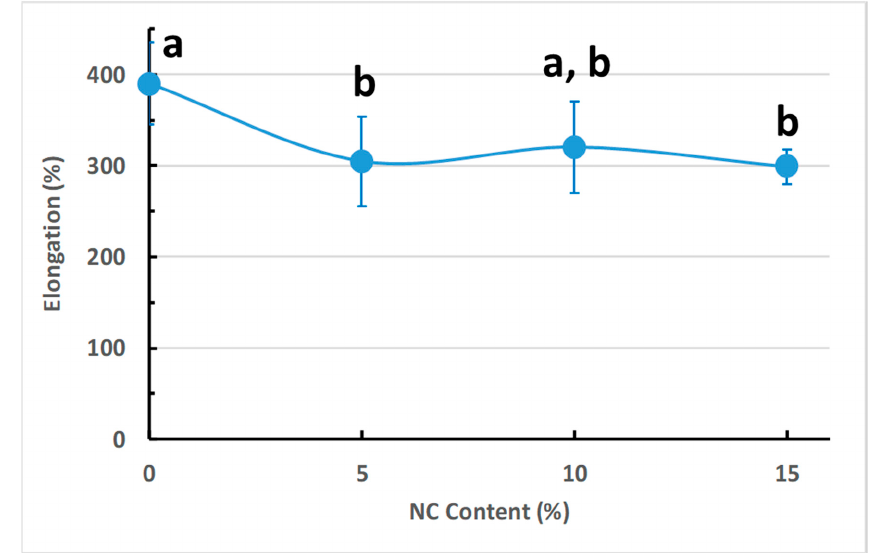
Figure 11. Percent elongation (ductility) of PVA materials as a function of nano-clay content. Error bars indicate the standard deviation in the average test values of 5 samples. Values with the same letter in the same row do not differ statistically by Tukey’s test ( p ≤ 0.05). Table 2. Mechanical properties for selected commercial polymer